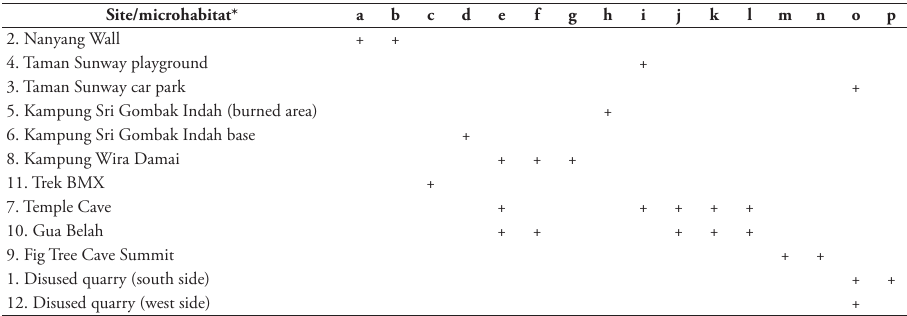
Table 3. Sites surveyed and their microhabitats.